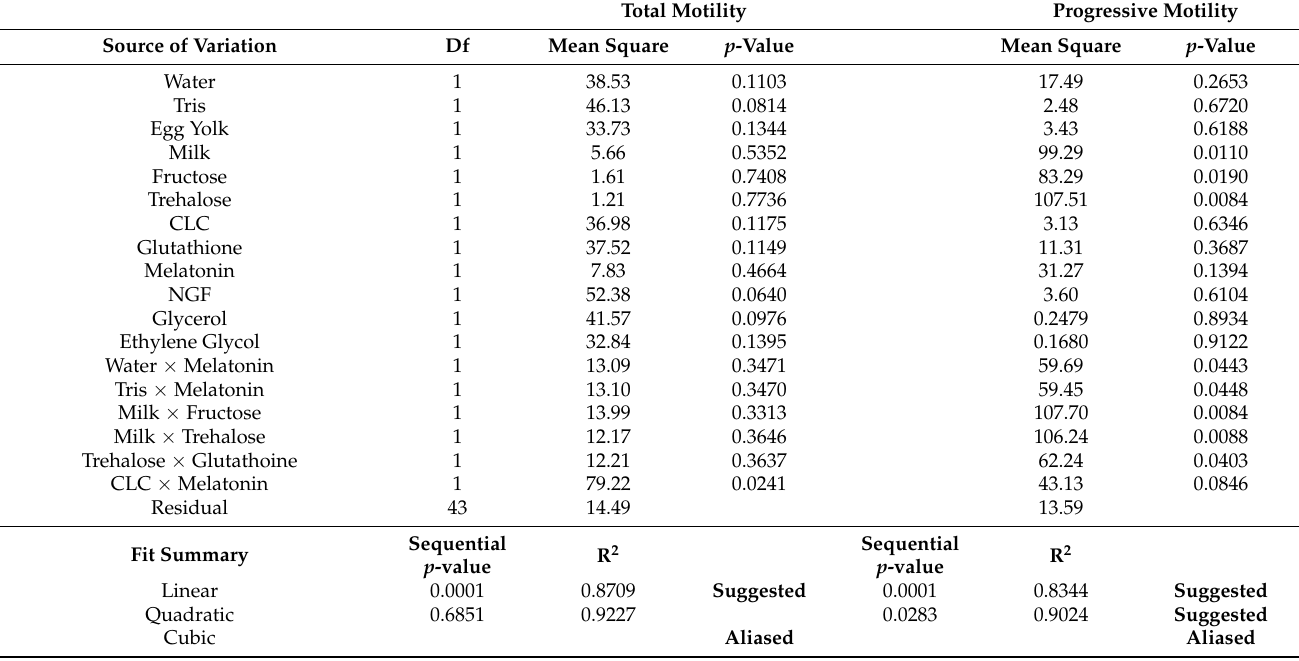
Table 1. Analysis of variance (Type III-Partial) of the main effects and some significant two-way interactions in terms of total motility and progressive